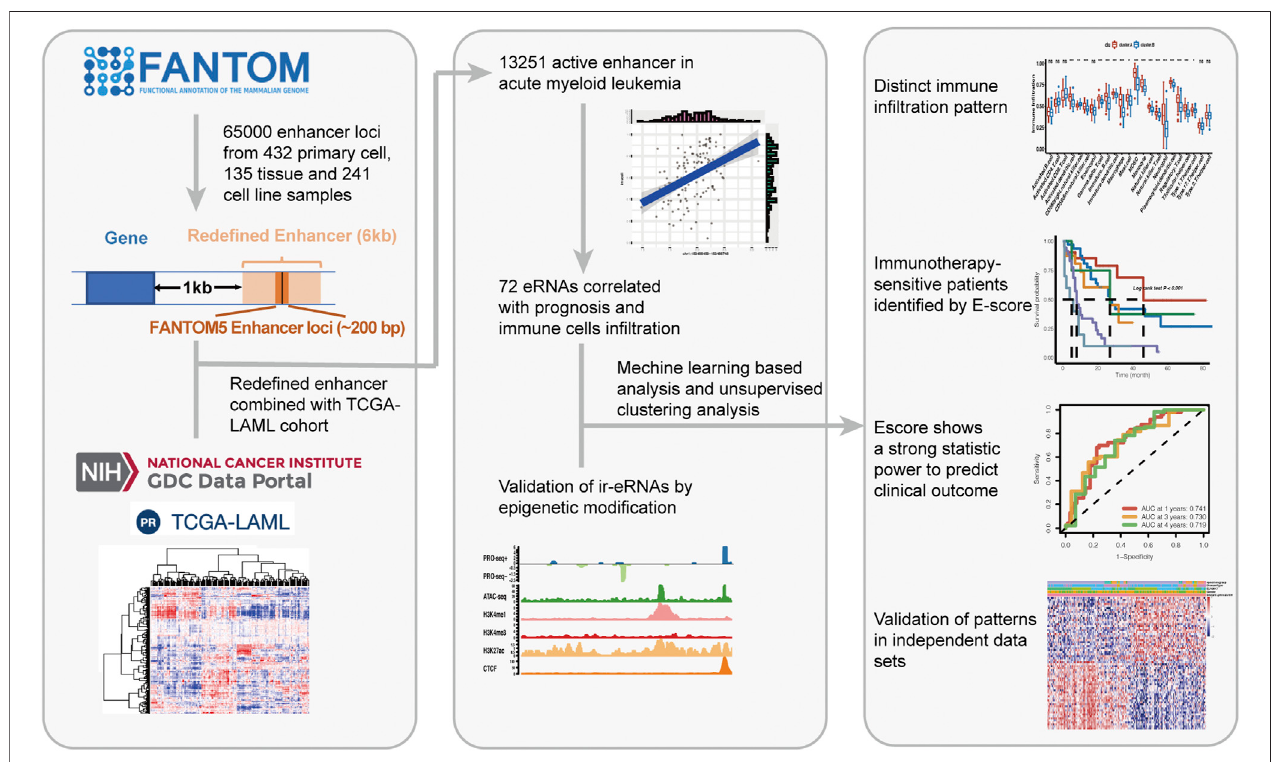
FIGURE 1 | Overview of the